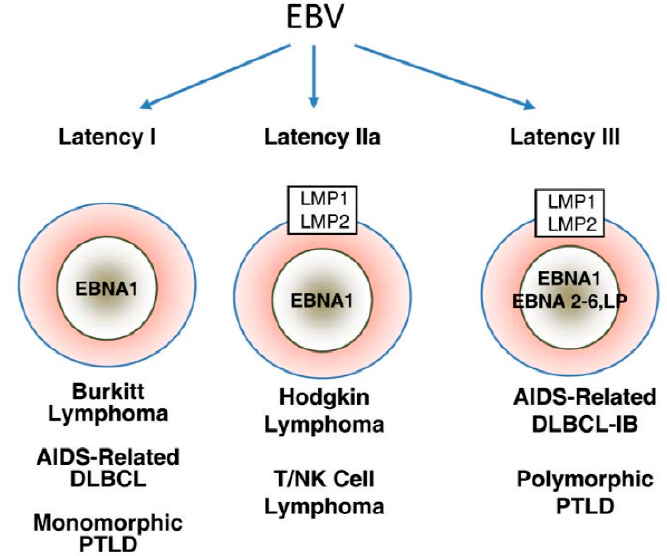
Figure 1. Major patterns of Epstein-Barr virus (EBV) latent gene expression in lymphoproliferative disorders. The main EBV latency patterns and the most common lymphoproliferative disorders in which these patterns are seen are illustrated. Reproduced with permission from Cesarman, E., Gammaherpesvirus and lymphoprolliferative disorders in immunocompromised patients; published by Cancer Lett. , 2011.